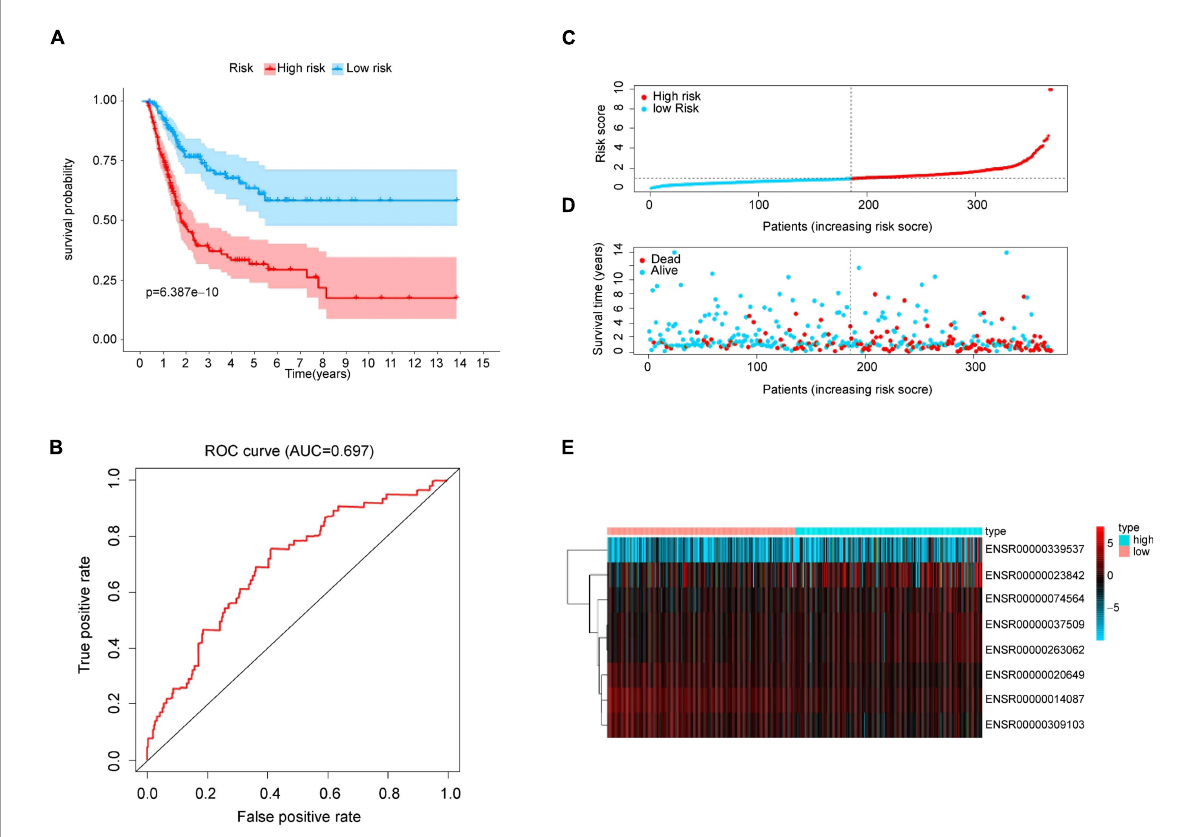
FIGURE2 Prognostic analysis from risk model. (A) Kaplan-Meier curve analysis of high-risk and low-risk groups. Light-colored background around the curves indicates 95% CI. (B) ROC curve of the prognostic model. AUC > 0.60 was regarded as acceptable for prediction. (C) Risk score distribution of bladder cancer patients based on the prognostic model. (D) Scatter plot of survival status of two risk groups. (E) Heatmap of eRNAs